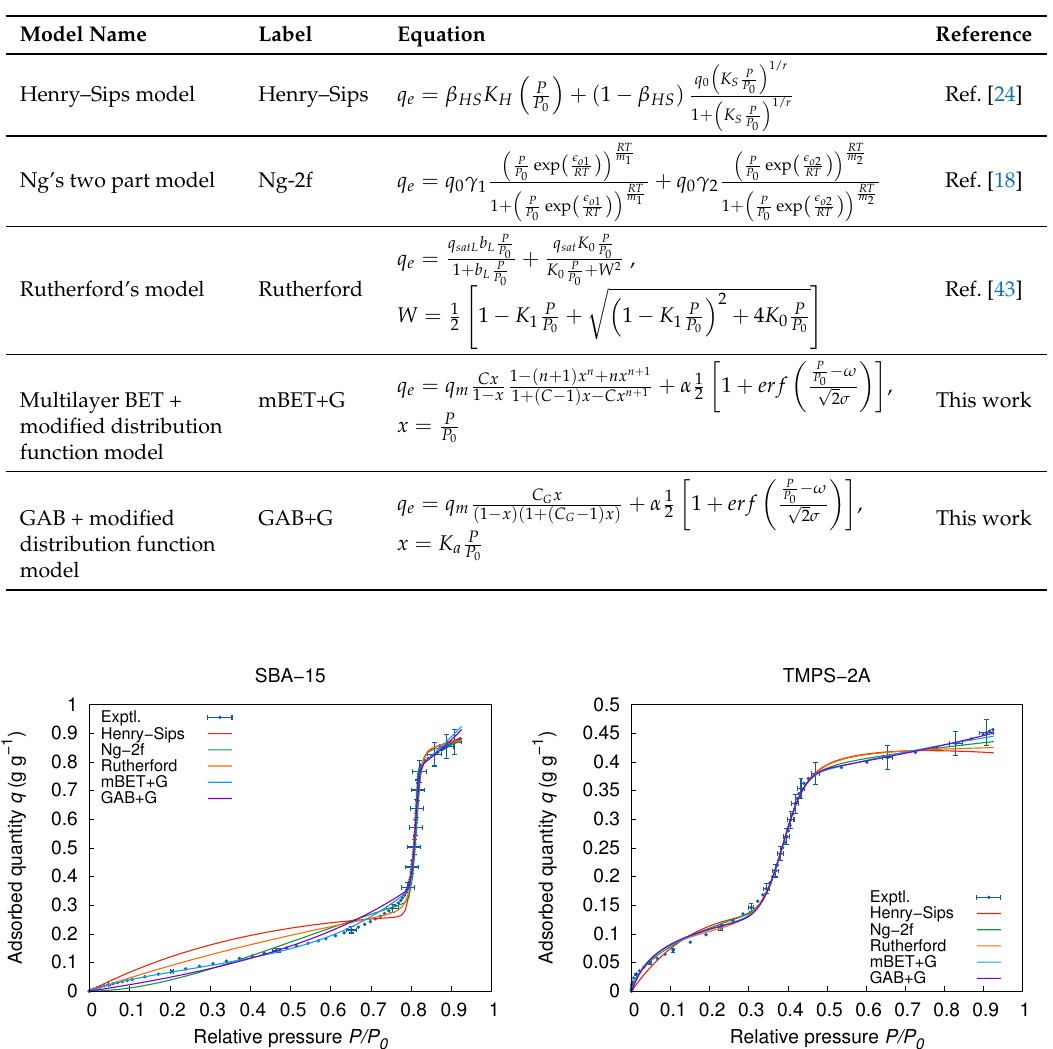
Table 2. Summary of the models in their final form for the comparative simulations.